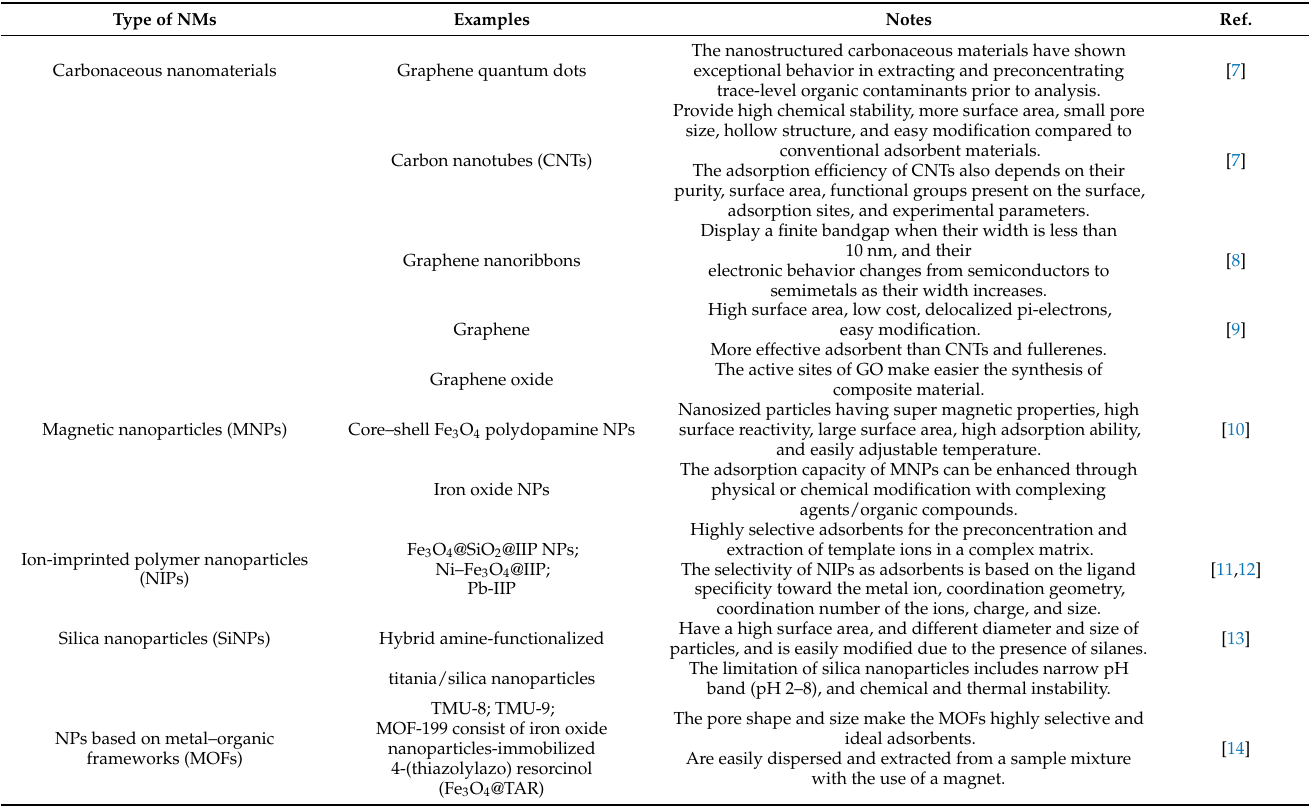
Table 1. Information on NMs classified in different